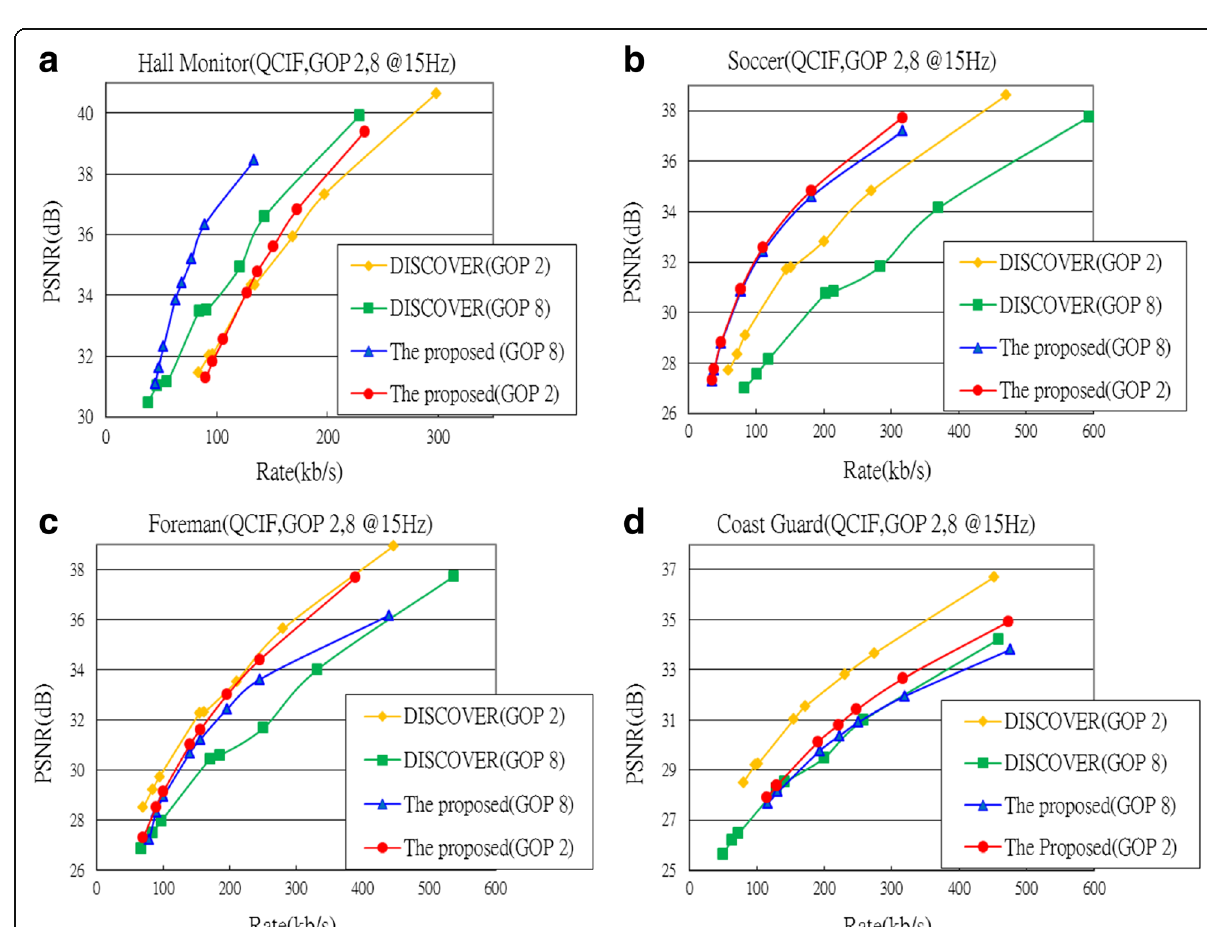
Fig. 9 The RD performance comparison of the proposed PB-based LVC and the DISCOVER